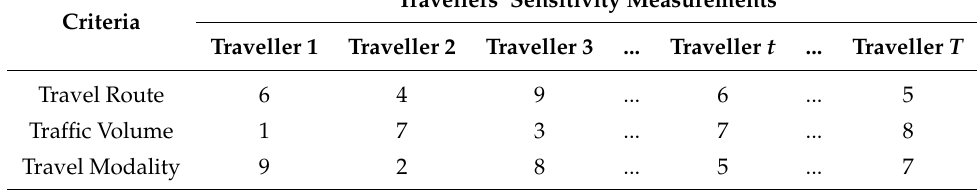
Table 1. Travellers’ sensitivity measurements.